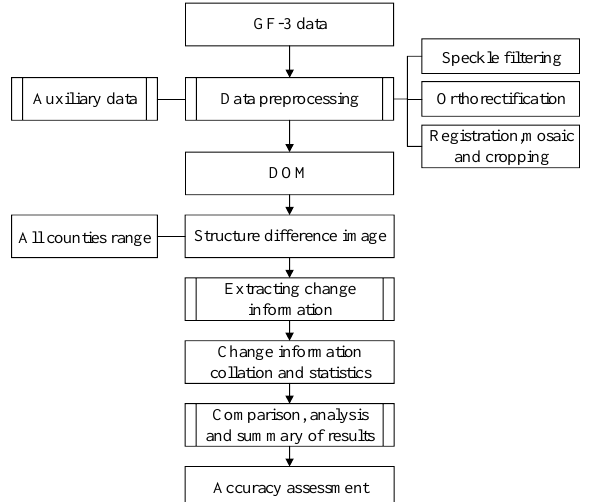
Figure 2. Flowchart of GF-3 change information extraction 2.1